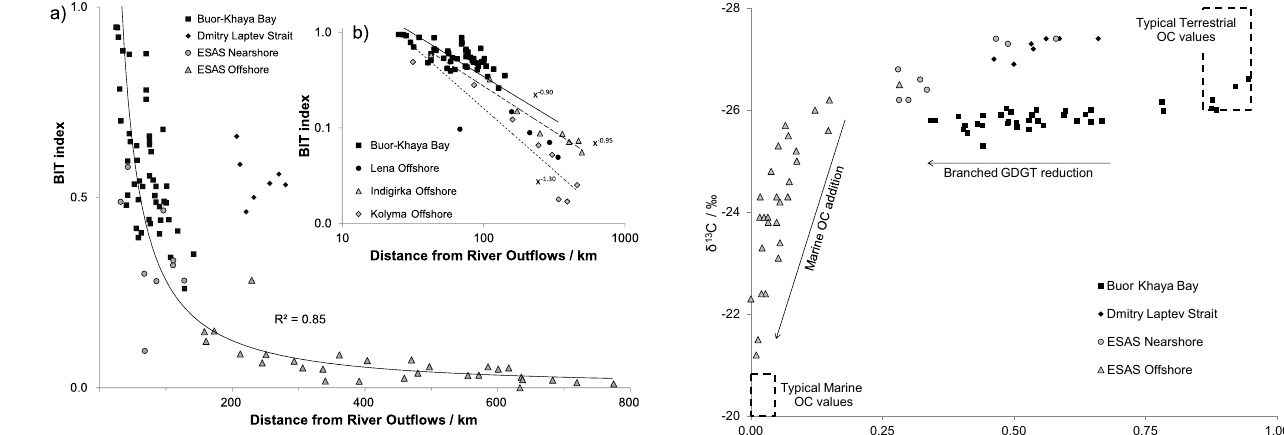
Figure 5. Plot of BIT index vs. linear distance from river mouths. (a) Plotted in linear space, showing the strong power-law relation- ship between the BIT and distance (with the exception of the DLS samples) and (b) plotted in log–log space. Outflows from the Lena, Indigirka and Kolyma rivers are comparable, with power-law coef- ficients labelled.